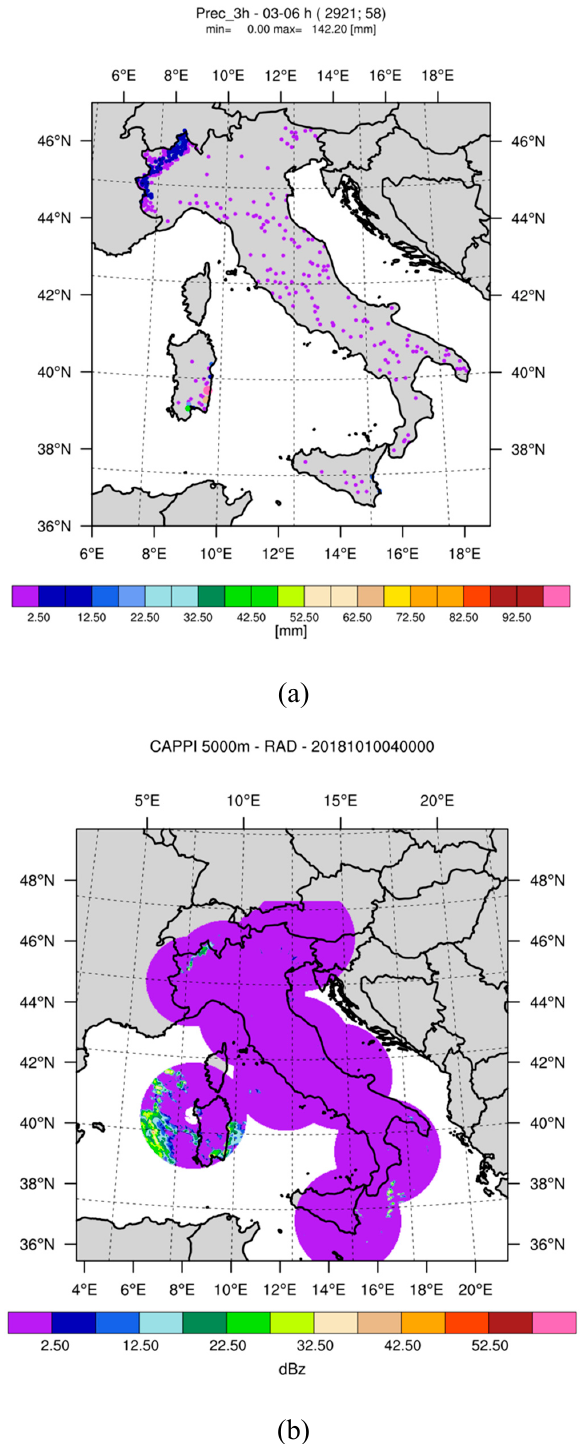
Figure 3. ( a ) Rainfall observed by the Italian rain gauge network between 03 and 06 UTC on 10 October; ( b ) CAPPI (Constant Altitude Plan Position Indicator) at 04 UTC on 10 October and at 5 km height. Radar composite is obtained from the 22 radars of the Italian network.